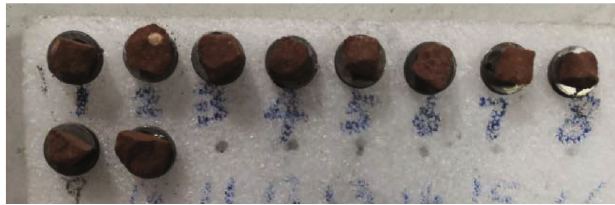
Figure 6: Specimens in SEM